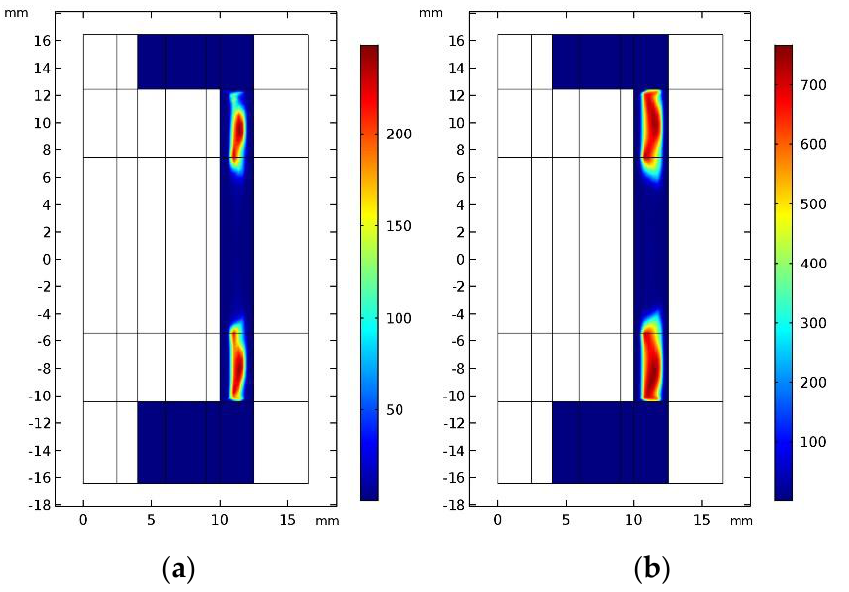
Figure 12. Dynamic viscosity distribution map of the MR fluid: ( a ) I = 1 A; ( b ) I = 2.5 A.